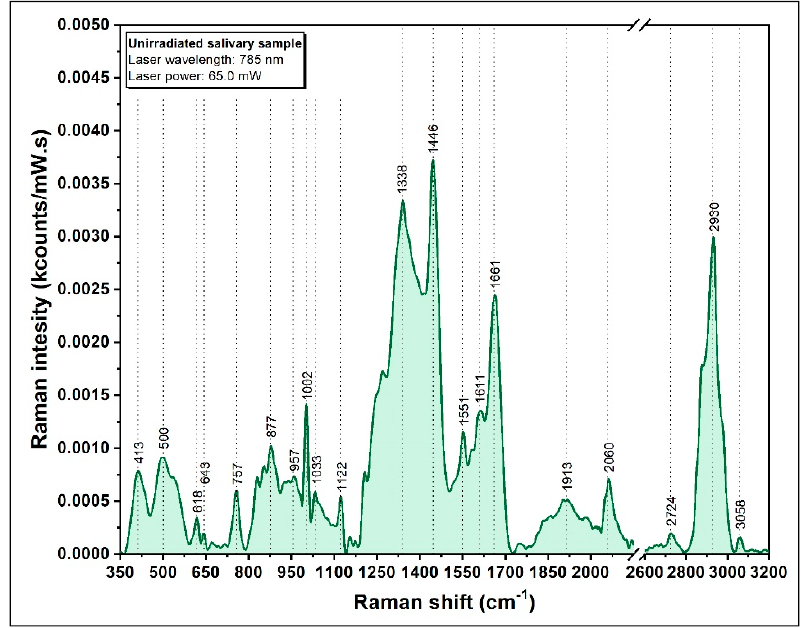
Figure 5. A typical Raman spectrum of dried saliva, recorded using a 785 nm laser.